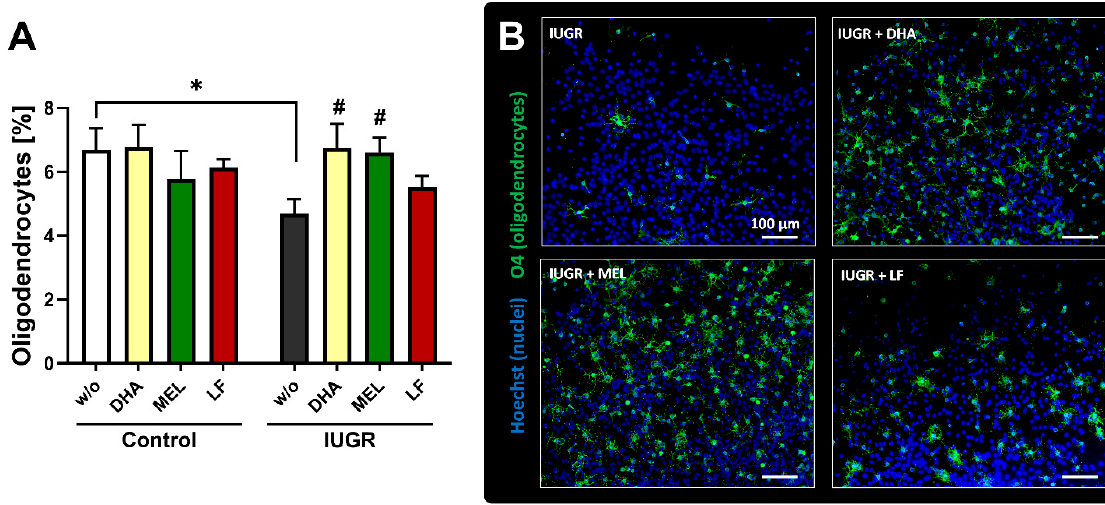
Figure 5. In vivo administration of selected therapies. Oligodendrocyte differentiation. Pregnant rabbits were administered to either MEL (10 mg /kg BW/day), DHA (37 mg/kg BW/day) or